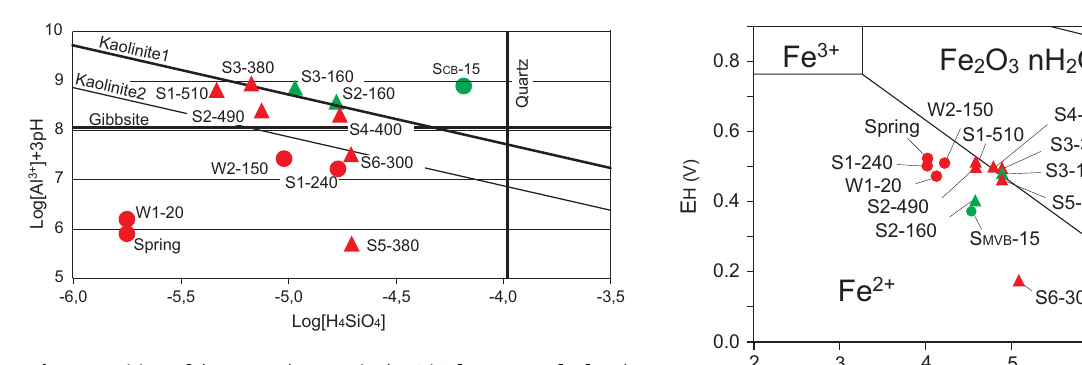
Fig. 7. Position of the groundwaters in the Si-Al system calculated from the average compositions without considering complexation by DOM. Red and green symbols indicate groundwaters follow- ing pathway No. 1 and No. 2, respectively. Triangular symbols indicate groundwaters supposed to be controlled by kaolinite dis- solution/precipitation, and circles indicate groundwaters with high DOC.